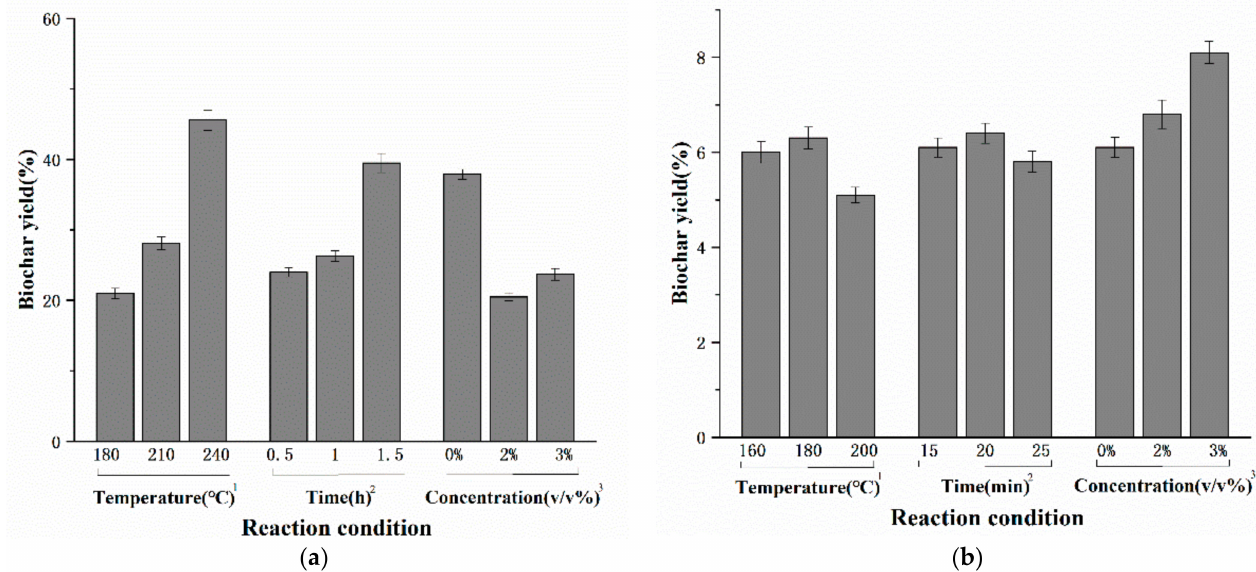
Figure 6. The yield of biochar produced from cooked steamed bread after the HTC process. ( a ): The HTC process is performed in HPR; ( b ): the HTC process is performed in MW. Values are presented as mean ± SD from three experiments. 1 Only the reaction temperature changed in the reaction conditions. The reaction time was 1 h, and the sulfuric acid concentration was 3 v / v %. 2 Only the reaction time changed in the reaction conditions. The reaction temperature was 210 ◦ C/180 ◦ C, respectively, and the sulfuric acid concentration was 3 v / v %. 3 Only the concentration of sulfuric acid changed in the reaction